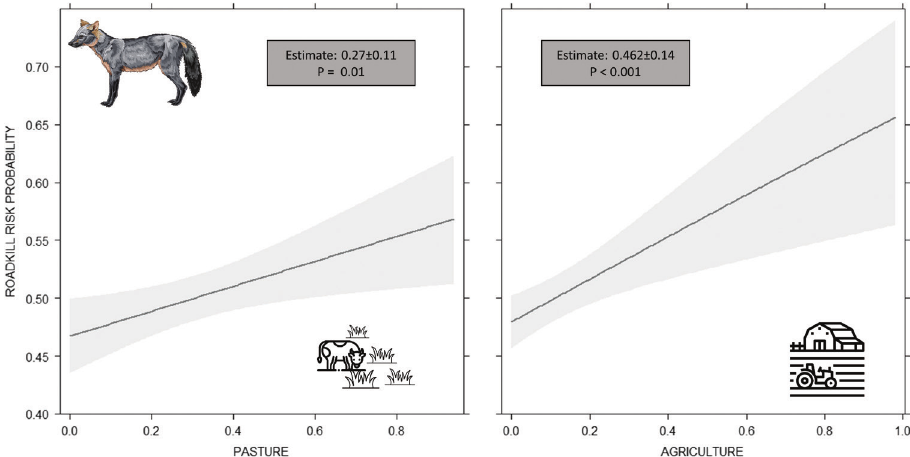
Figure 3. Best model selected by AIC for C. thous and its estimated coefficients. A model with two variables responded better to C. thous roadkill risk, being pasture and agriculture positively related to roadkill